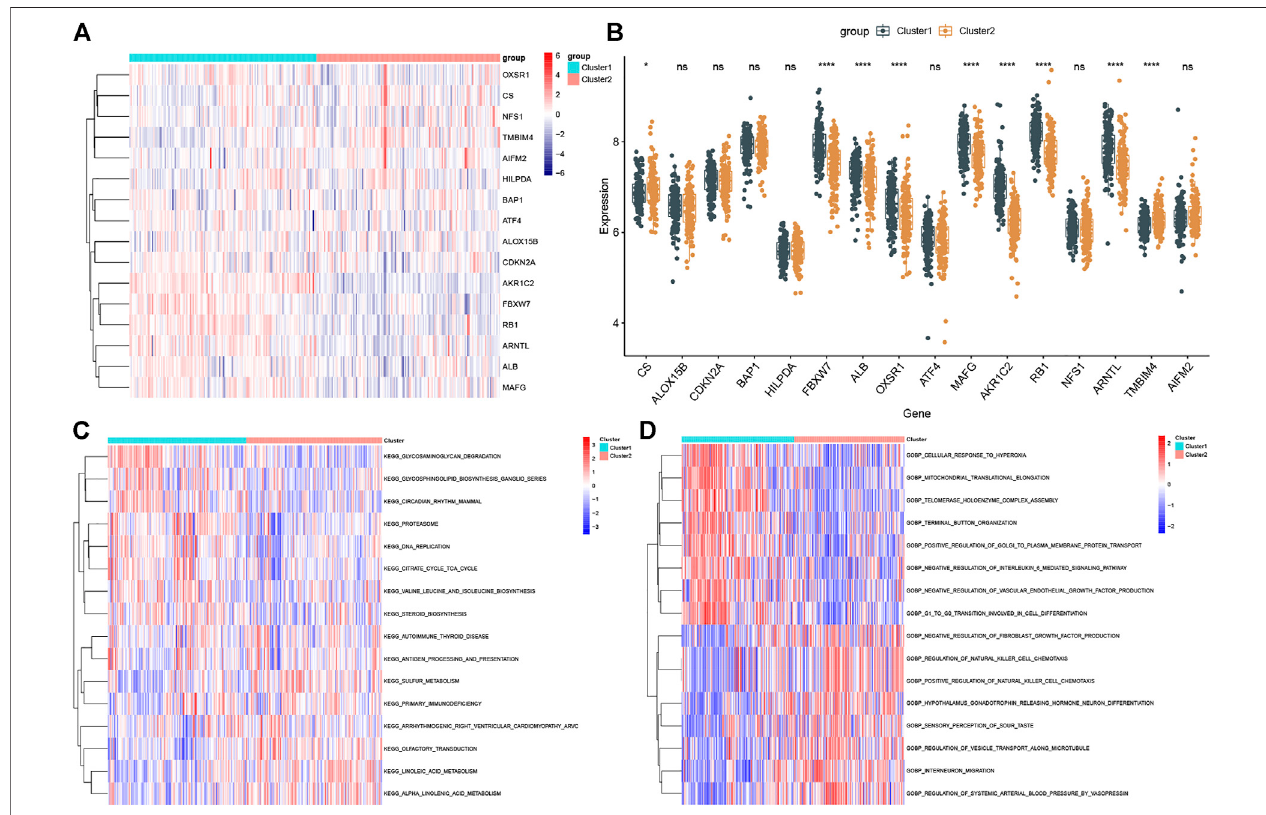
FIGURE 5 | Biological characteristics between the two ferroptosis clusters. (A and B) Representative heatmap (A) and box plots (B) of 16 FRGs between the two ferroptosis clusters. * p < 0.05, **** p < 0.0001, ns, no signi fi cance. (C and D) GSVA analysis showing signi fi cantly activated pathways (C) and biological functions (D) in different ferroptosis